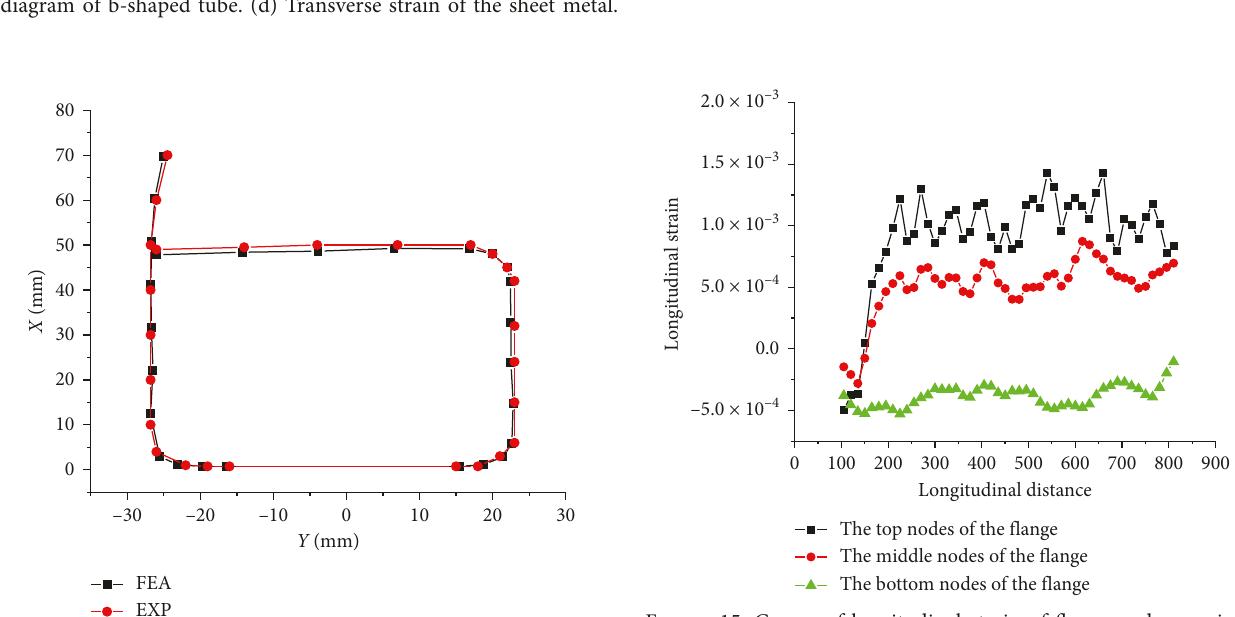
Figure 15: Curves of longitudinal strain of flange nodes varying with longitudinal